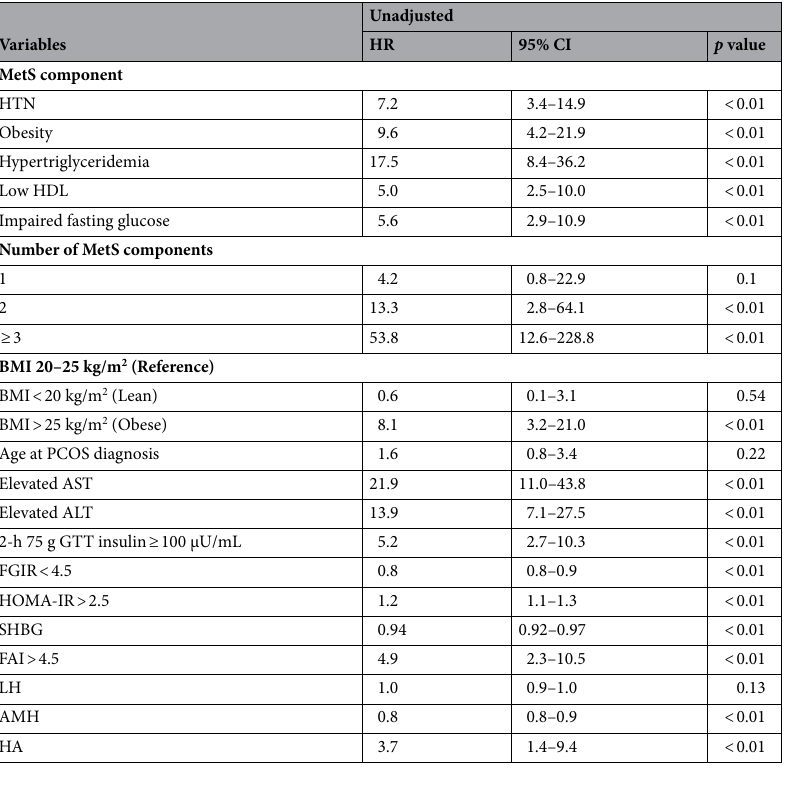
Table 3. Univariate analysis of variables associated with NAFLD development in PCOS patients. The categorical variables were MetS component (reference: none), number of MetS components (reference: number 0), Age at PCOS diagnosis (reference: adolescent), Elevated AST (reference: normal AST level at PCOS diagnosis), Elevated ALT (reference: normal ALT level at PCOS diagnosis), 2-h 75 g GTT insulin (reference: < 100 µU/mL), FAI (reference < 4.5), HA (reference: none). ALT alanine aminotransferase, AMH anti-Müllerian hormone, AST aspartate transaminase, CI confidence interval, FAI free androgen index, FGIR fasting glucose insulin ratio, HA hyperandrogenism, HDL high-density lipoprotein, HOMA-IR homeostasis model assessment of insulin resistance, HR hazard ratio, HTN hypertension, GTT glucose tolerance test,